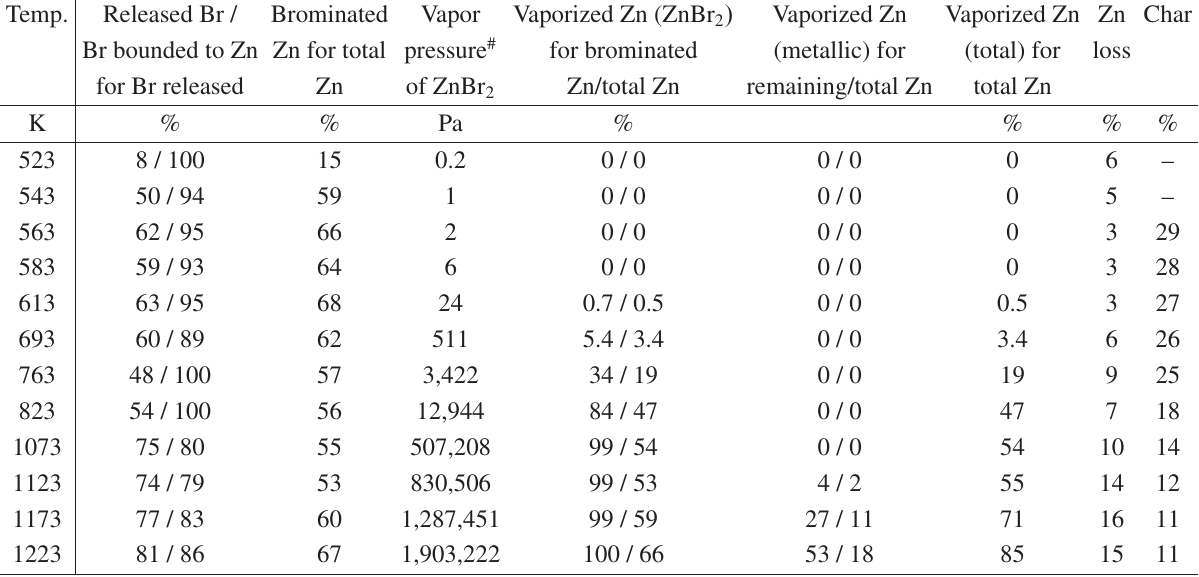
# The vapor pressures of ZnBr 2 were calculated according to equation given in [32]. Table 2. Bromination and vaporization of zinc during isothermal treatment of TBBPA and ZnO (3.34:1) in Argon atmo- sphere for 40 min at various conditions, expressed as percentages.